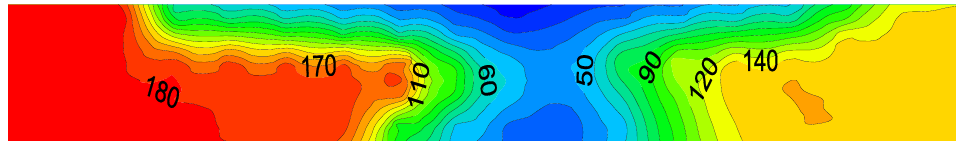
Figure 2. Temperature distribution when the high temperature fronts made contact with each other.